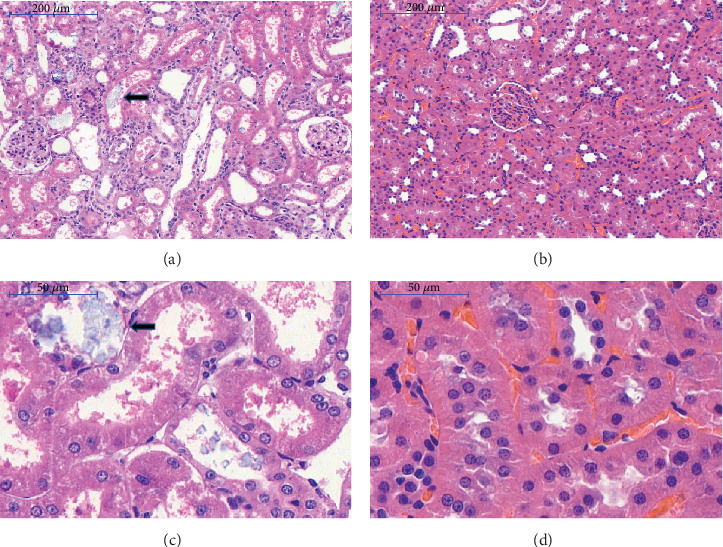
Histopathological changes in the kidney of rats after a 28-day administration of 1% EG or saline. Black arrows in a and c indicate the deposition of a large amount of calcium oxalate crystal in the nephrolithiasis group; control group showing the normal renal tubule (b, d). Microscopic images are representative of n = 4 in each group.